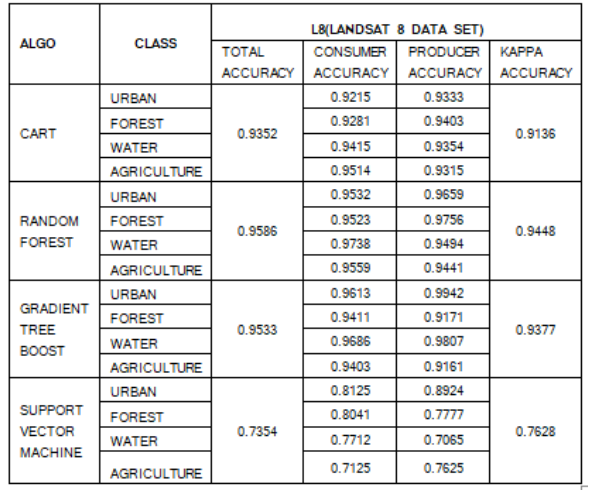
Figure 11: Accuracy generated by classification algorithms over landsat-8 datasets